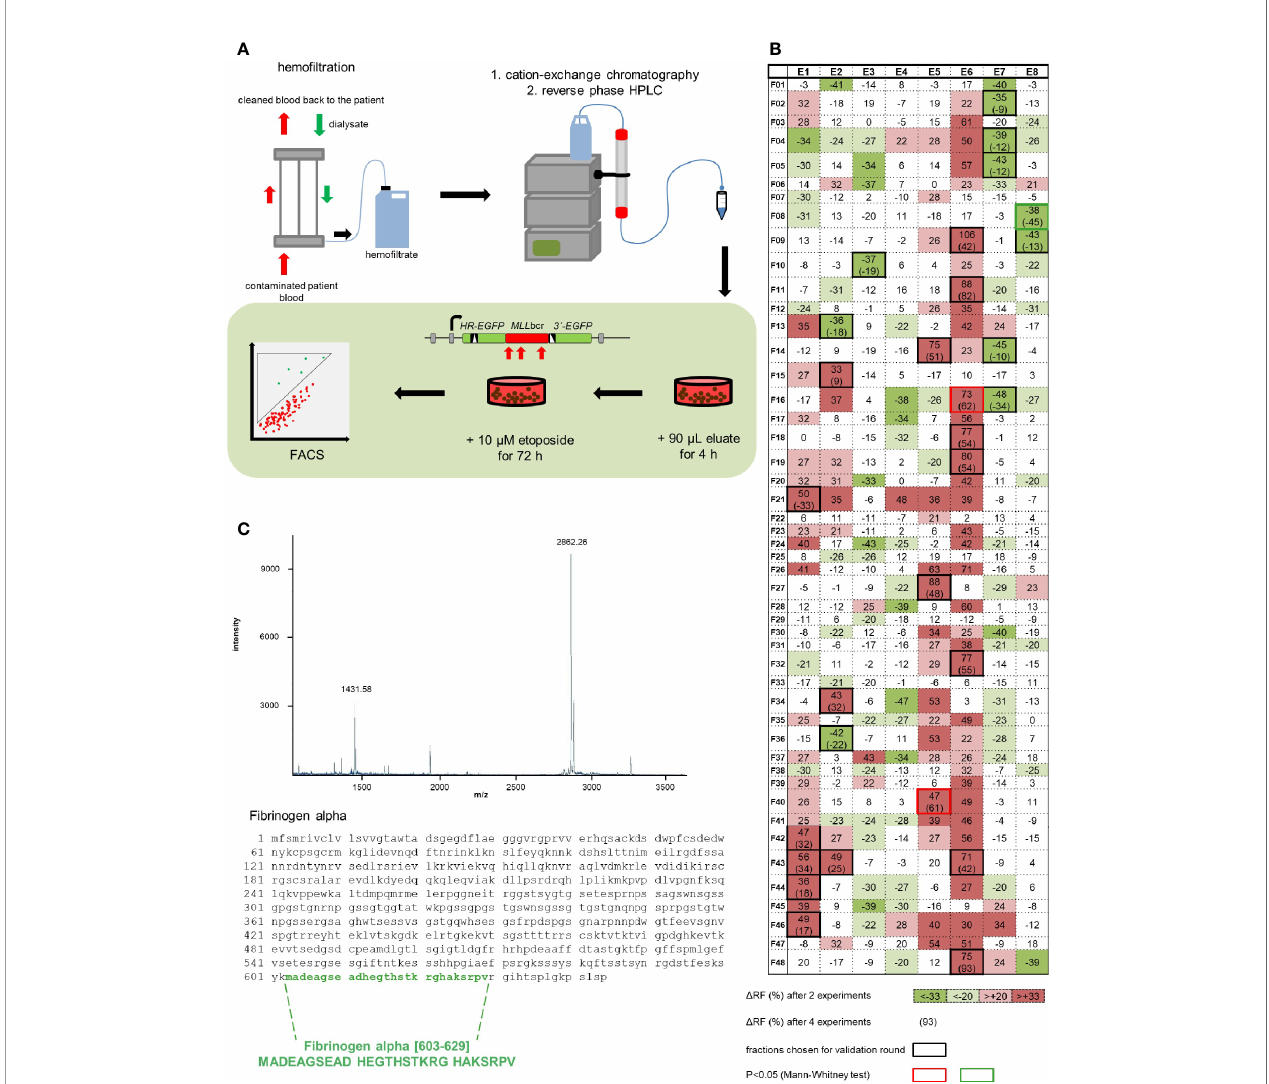
FIGURE 1 | Identi fi cation of a human peptide fromhemo fi ltrate reducing etoposide-induced rearrangements at the MLL bcr. (A) Principleofthe peptide screen.Hemo fi ltrate was subjectedto cation exchange chromatography and subsequent reversed phase high-performance liquid chromatography (HPLC) resulting in 384 eluate fractions, of which an aliquot of 90 µl each was addedto a 2 ml culture of the cell line K562MLL with chromosomally integratedEGFP-based reporter construct for MLL bcr rearrangements. After a pre-treatment for 4 h the chemotherapeuticdrugetoposide (10 µM) was included for 72 h. EGFP gene reconstitution was triggered by etoposide- induced MLL bcr breakage and recombination between two differentially mutated EGFP genes adjacent to the MLL bcr. MLL bcr rearrangements were thus measured as recombination frequencies determining thefraction ofgreen fl uorescent cells compared to the total population of live cells (FSC/SSC gate) by FACS analysisusing the diagonal FL1-FL2 Dot Plot gate. (B) First round screeningpattern. Relative changes of etoposide-induced recombination with versus without preincubation of cells with eluate are indicated for each HPLC fraction in %. Statistical signi fi cances of differences between mean recombination frequencies from two independentexperiments according to c 2 test are visualized bygradual color changes, whereby red indicates increased and green decreasedetoposide-induced recombination.For fractionswith mean difference ( D ) ≥ 33% (p< 0.05 or SD< D ) validation experiments were performed (black frames) resulting in n=4 (red or green frame: p<0.05 according to Mann-Whitney U test). (C) Identi fi cation of Fibrinogen alpha [603-629] bymass spectrometry (MALDI-MS) andEdman analysis offraction E8F08 after HPLCpuri fi cation.The MALDI-MS spectrum shows the single andthe doublecharged peptide with a molecular weight of2862 Darepresenting a C-terminal portion of fi brinogen a . See also Figure S1